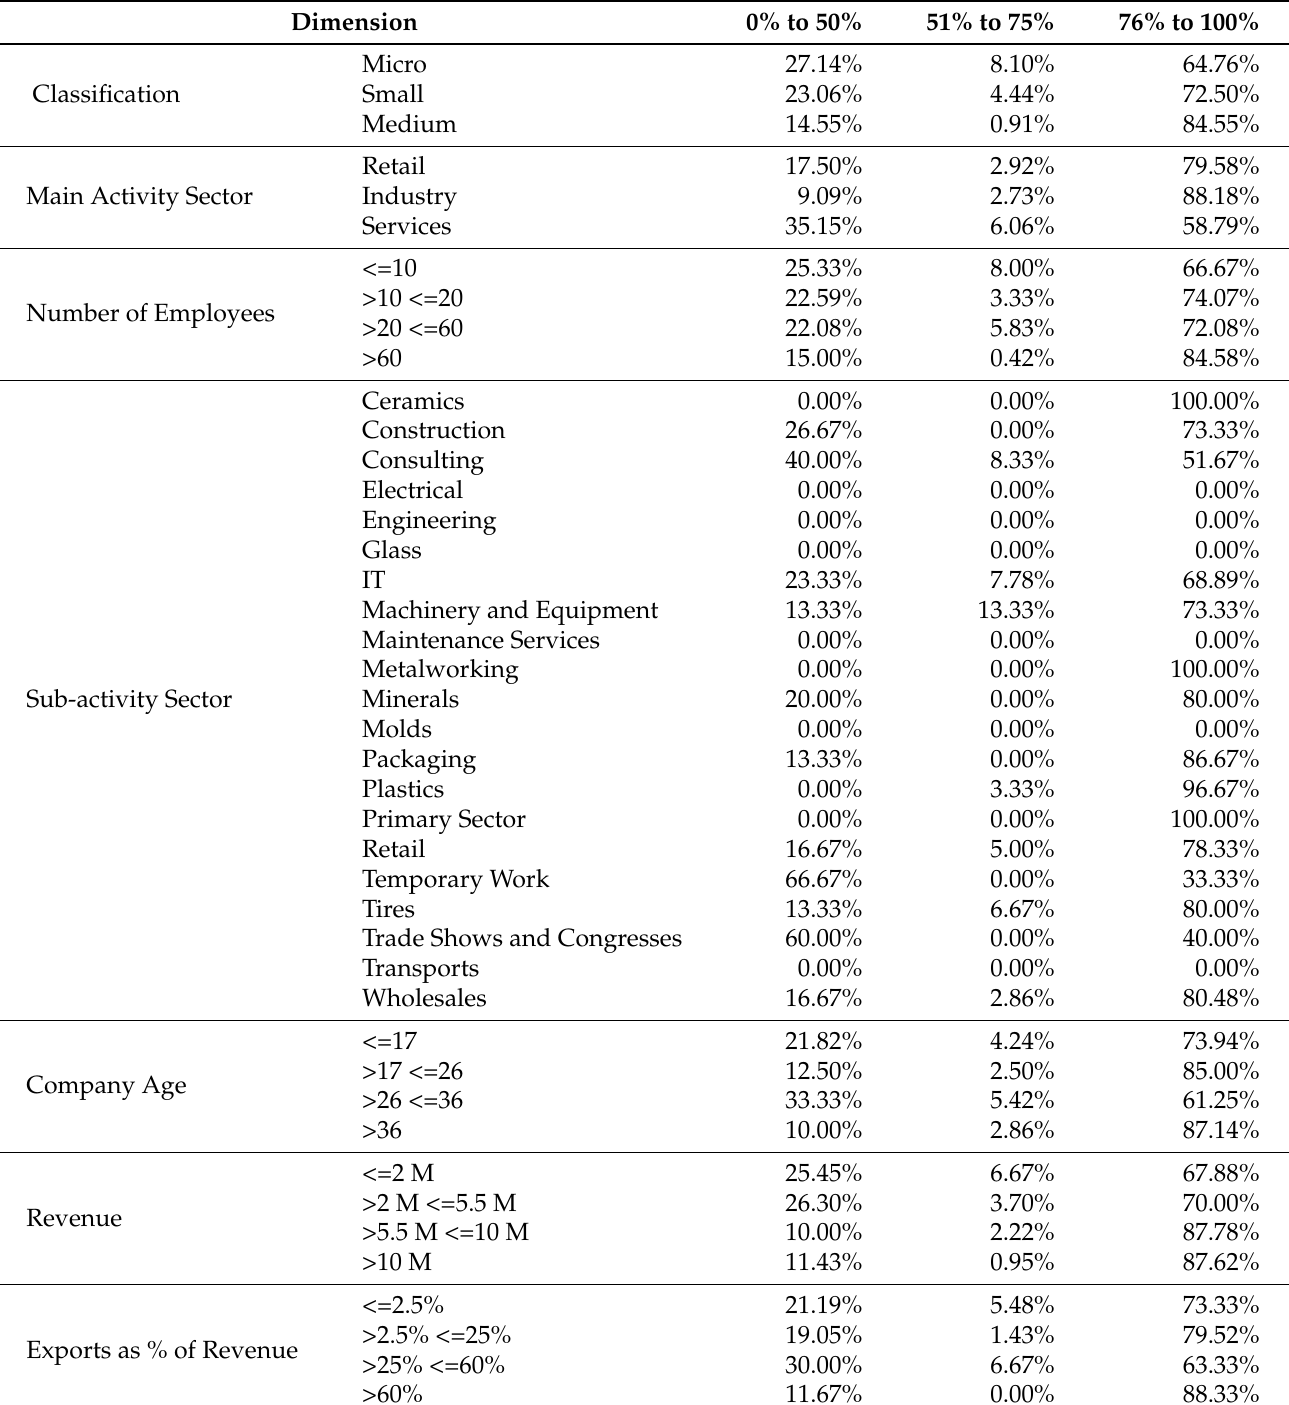
Table 2. Type 1—Acceptance percentage intervals of the controls in the predefined